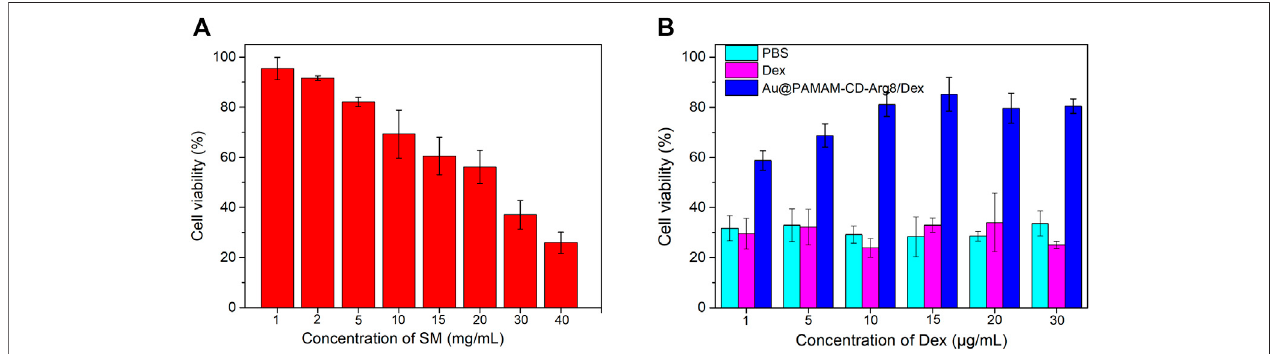
FIGURE 8 | (A) Ototoxicity induced by SM at different concentrations. (B) Therapeutic effects of Dex alone and Au@CD-PAMAM-Arg8/Dex on streptomycin